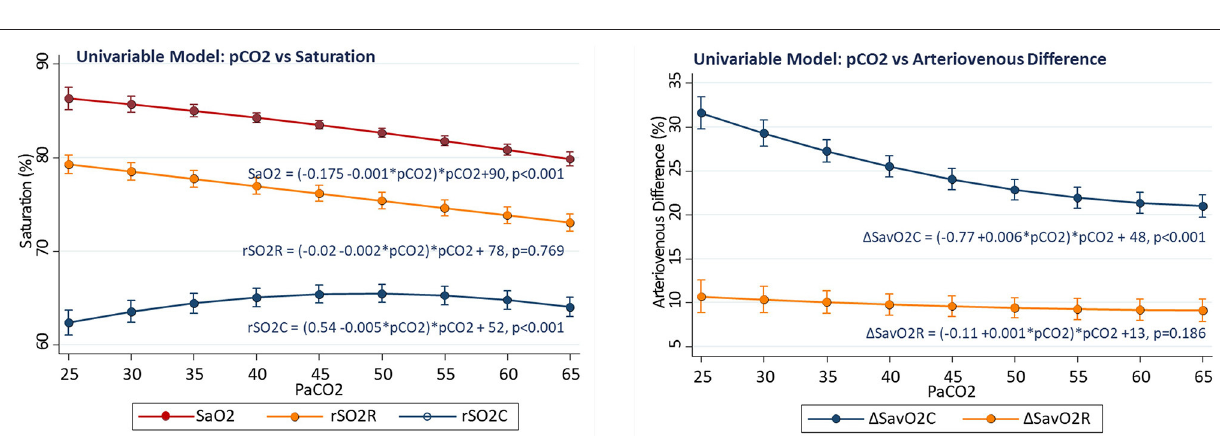
FIGURE 1 | Changes in regional oxygenation and arteriovenous difference with time in univariable models.